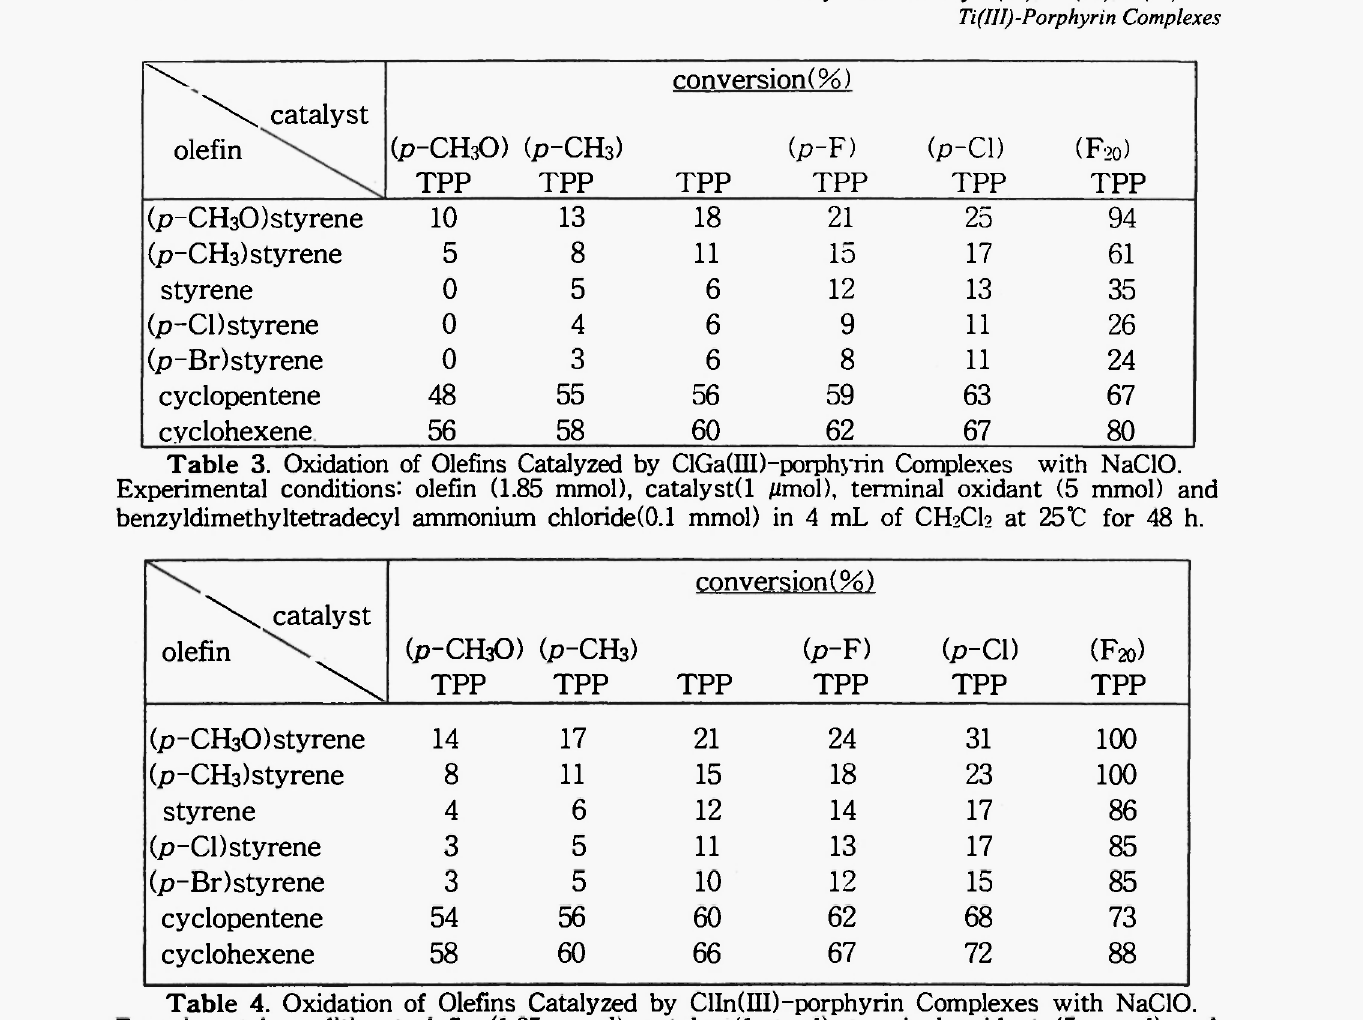
Table 4. Oxidation of Olefins Catalyzed by ClIn(III)-porphyrin Complexes with NaClO. Experimental conditions: olefin (1.85 mmol), catalystü /imol), terminal oxidant (5 mmol) and